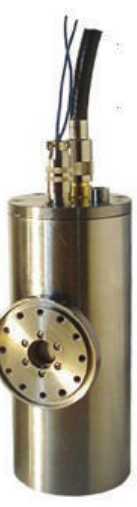
Figure 3: XY-501 X-ray tube.